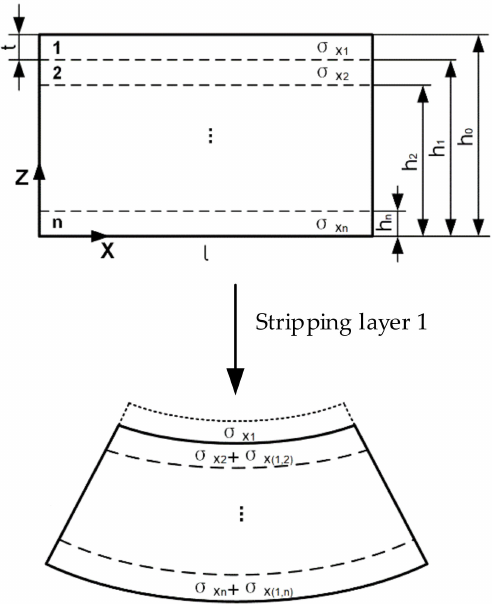
Figure 5. Stress redistribution and corresponding